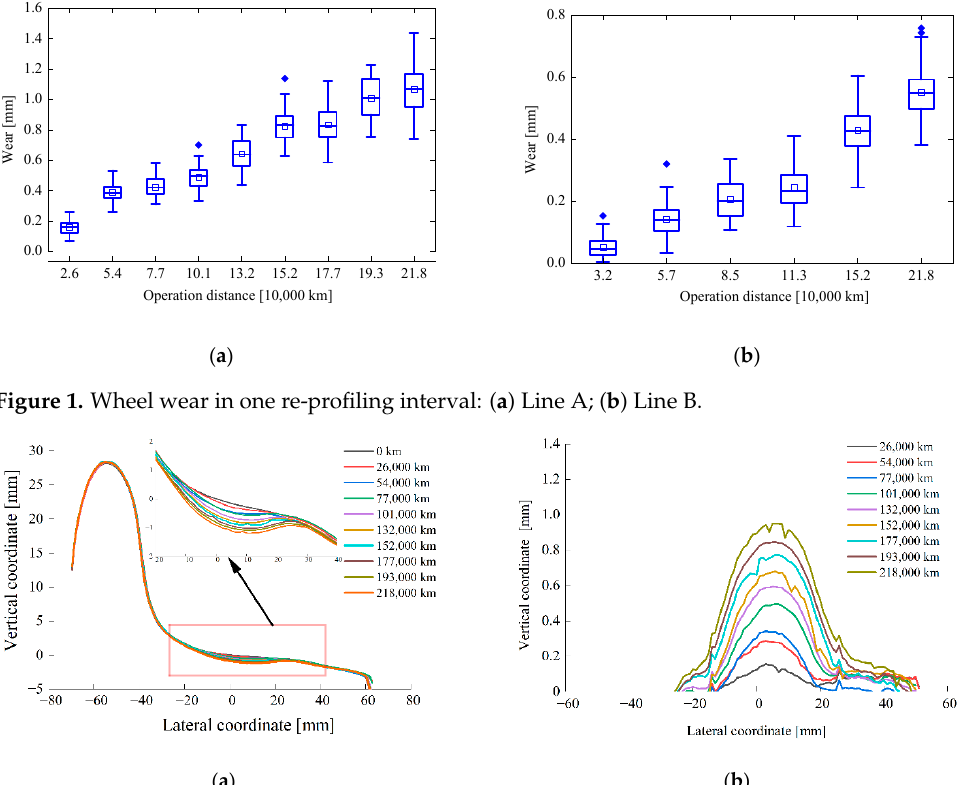
Figure 1. Wheel wear in one re ‐ profiling interval: ( a ) Line A; ( b ) Line B. Similarly, in the Line B, the wheel wear rate is segmentally linear: the wheel wear